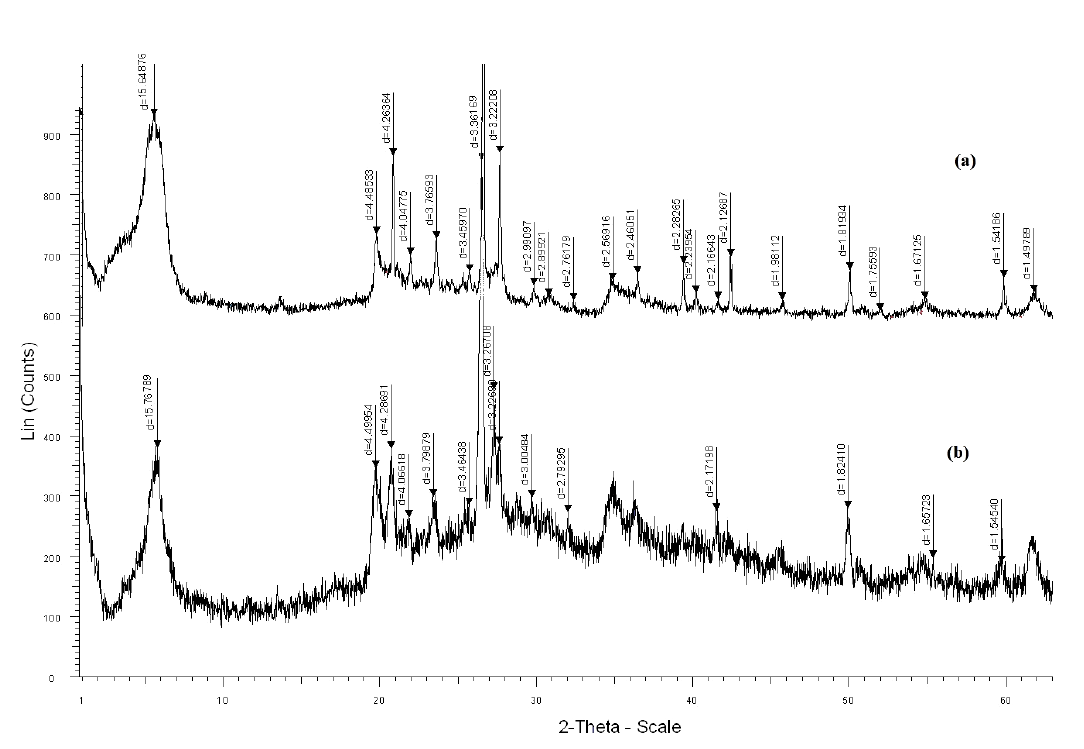
Figure 2. X-ray powder Diffractions of Maghnite-H + (a) and Maghnite-H + /Polymer mixture after the reaction (b) (recorded on a Philips PW 1710 diffractometer using Cu- Kα radiation (λ=1.5418A°), d is reported in A°)